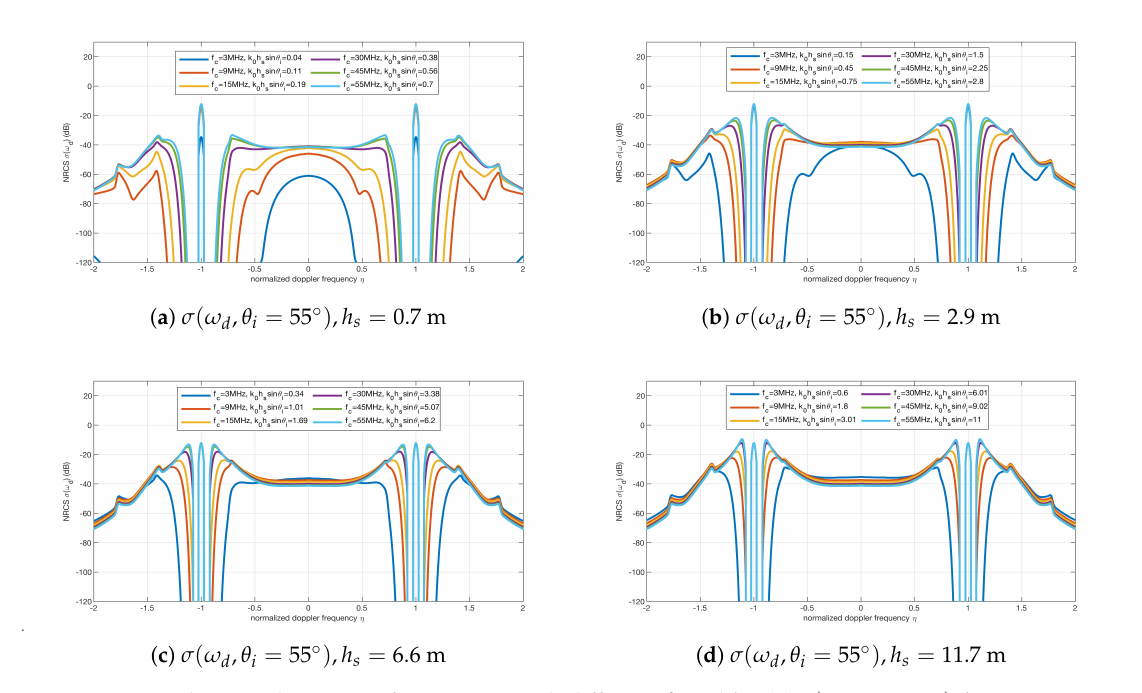
Figure 5. The Doppler spectra for θ i = 55 ◦ with different f c and h s . ( a ) σ ( ω d , θ i = 55 ◦ ) , h s = 0.7 m; ( b ) σ ( ω d , θ i = 55 ◦ ) , h s = 2.9 m; ( c ) σ ( ω d , θ i = 55 ◦ ) , h s = 6.6 m; and ( d ) σ ( ω d , θ i = 55 ◦ ) , h s = 11.7 m. For each pair of θ i and h s , six radar frequencies were selected to simulate the spectra. The six values of f c were 3, 9, 15, 30, 45 and 55 MHz. The dominant wave direction α (cid:48) is 90 ◦ .